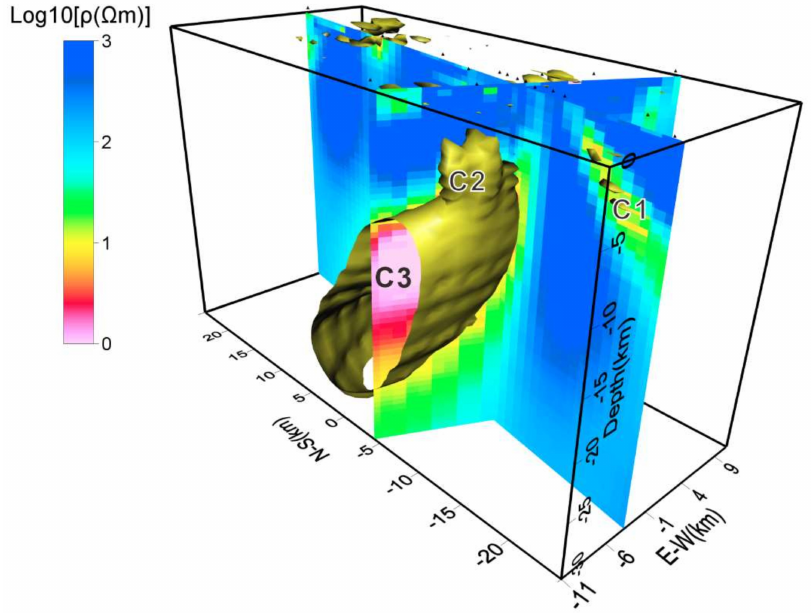
Figure 9. ( a , b ) Topography along the MT profiles. ( c , d ) Cross-section with the MT sites (triangles on top of the panel) extracted from the final model along the MT profiles (Lines AA’ and BB’ in Figure 7f). The red and black solid line represents fault. The white circle represents the epicenter of the 1866 M7.3 earthquake. ( e ) P (blue line) and S (red line) wave velocity structures beneath the seismic site (red triangle in Figure 3)